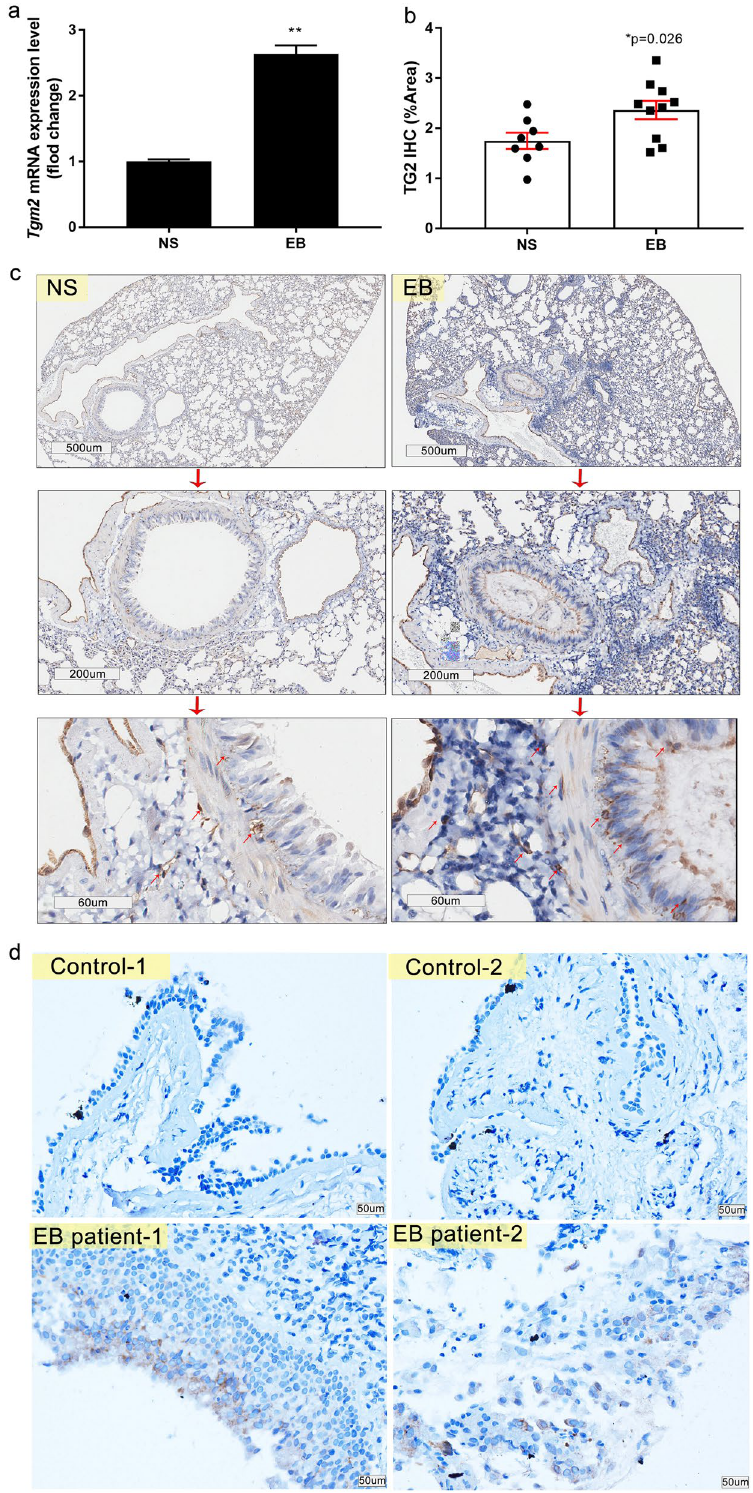
Figure 5. TG2 is up-regulated in the lung of EB mice and in the bronchial epithelial cells of EB patients. ( a–c ) The steady-state mRNA expression levels of TG2 in mice lung were determined by RT-qPCR ( a ) (figure representative of three dependent experiments) and the semi quantitative level of TG2 protein by immunohistochemistry was quantified ( b ) (n ≥ 8), and typical micrographs are presented (up, 40 × ; middle, 100 × ; and down, 400 × magnification.Arrows showed the location of TG2 positive signal) ( c ). ( d ) TG2 protein expression levels and location were also determined through immunohistochemistry on bronchial brush slices from non-EB control and EB patients (200 × magnification). (* P ≤ 0.05; ** P < 0.01). The scale is indicated on the panel by the length of the box around the size in